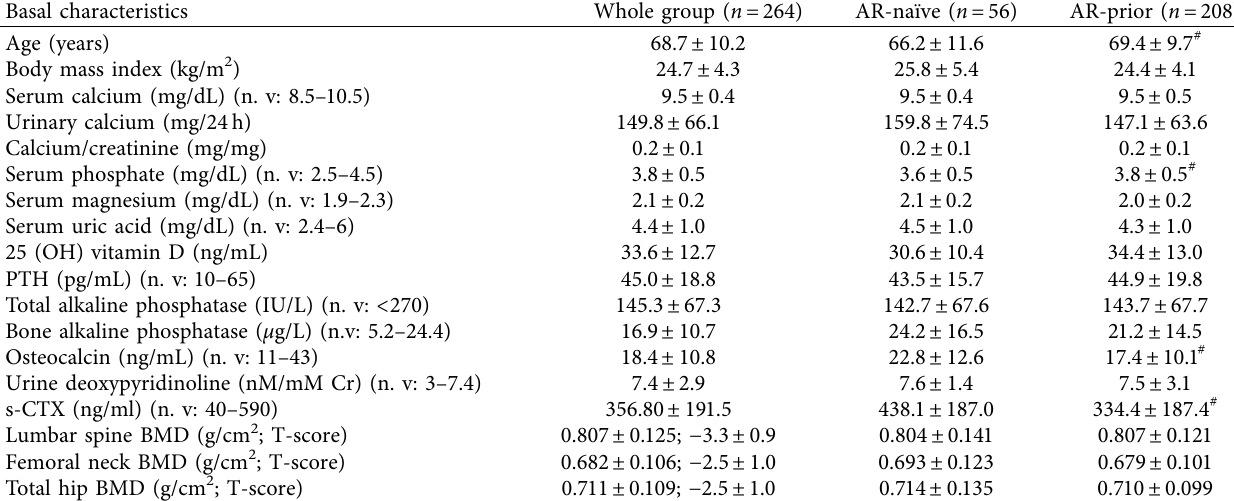
Table 1: Baseline biochemical parameters and BMD in the whole group of patients under teriparatide, and separately, in those with (AR-prior) and without (AR-na¨ıve) previous antiresorptive